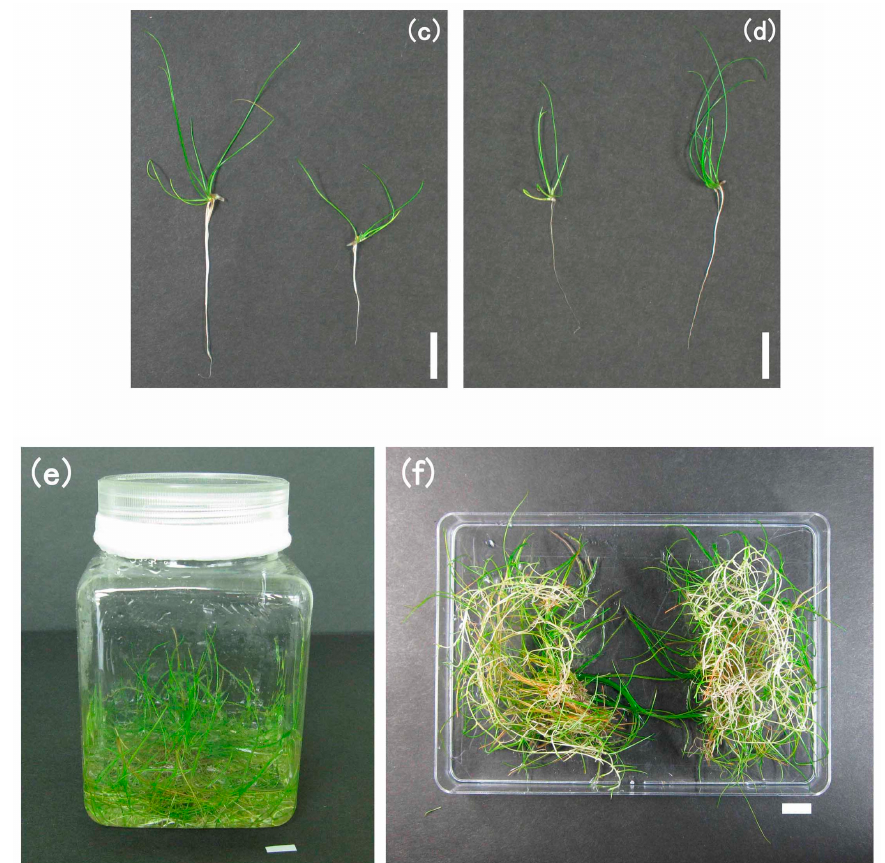
Figure 2. ( a ) The ratio of explants in three conditions: living, dead, or contaminated with microbes after primary culture. The explants were excised from young ramets and cultured on solid medium for 7 days. The numbers of the replicates are shown in the graph. This result is representative of two experiments. ( b ) Comparison between explants excised from stolon tips and young ramets for primary culture. The ratio of explants for their conditions, i.e., living, dead, or contaminated with microbes. The explants were cultured on solid medium for 28 days ( n = 55). ( c ) Ramets grown from explants of young ramets in 31 days. ( d ) Ramets grown from explants of stolon tips in 31 days. ( e ) The plant community was subcultured and grown for 3 weeks in the plastic container. ( f ) Reversed and divided plant communities grown for 3 weeks after subculturing for the next subculture. Bar = 10 mm ( c – f ).